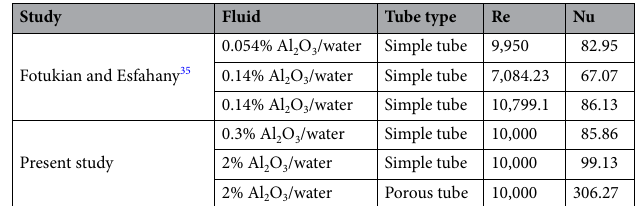
Table 2. Nusselt number calculation (CFD and experiment